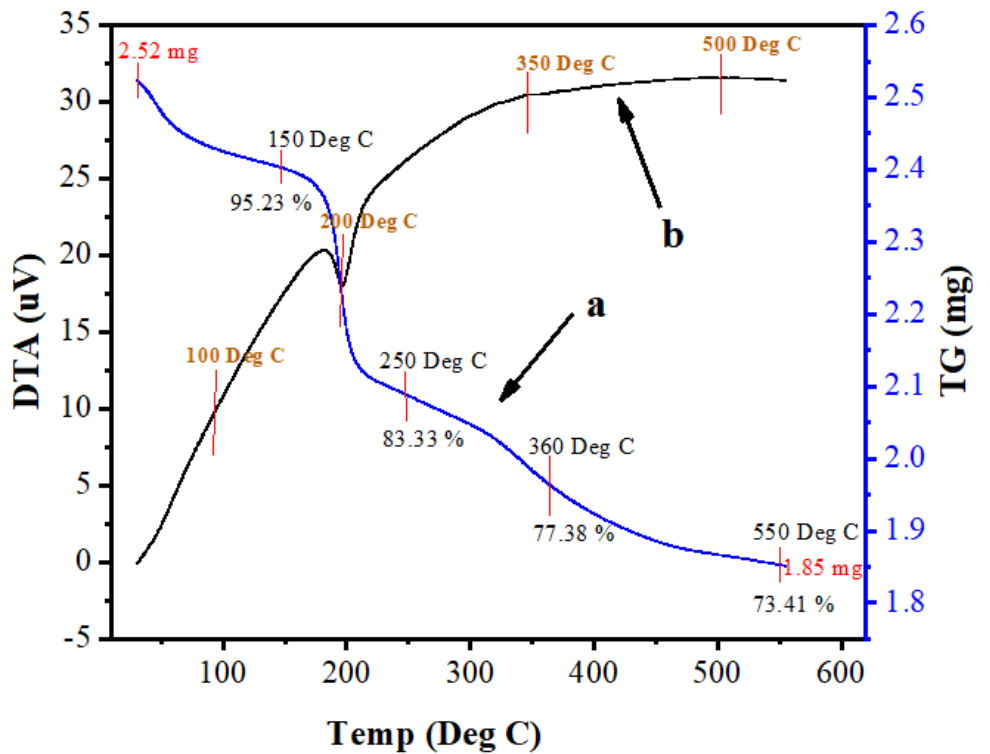
Figure 8. Thermogravimetric analysis (TGA, a ) and differential thermal analysis (DTA, b ) of Mn:ZnS QDs.